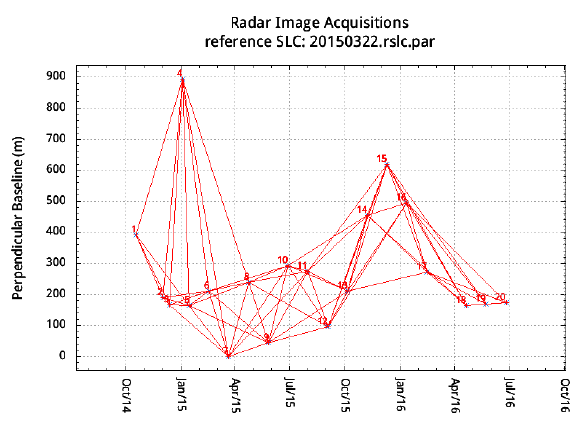
Figure 3. Connection diagram